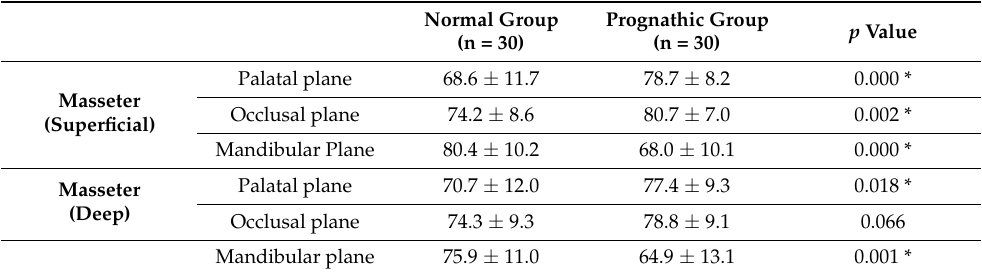
Table 2. Angle between the masseter muscle and the reference planes.